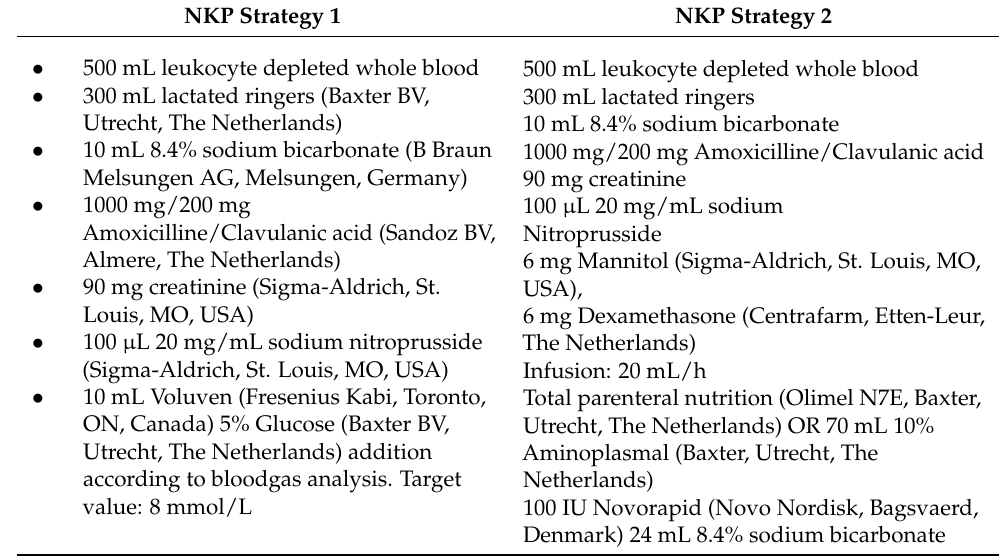
Table 2. Perfusion solution characteristics of the two different normothermic perfusion